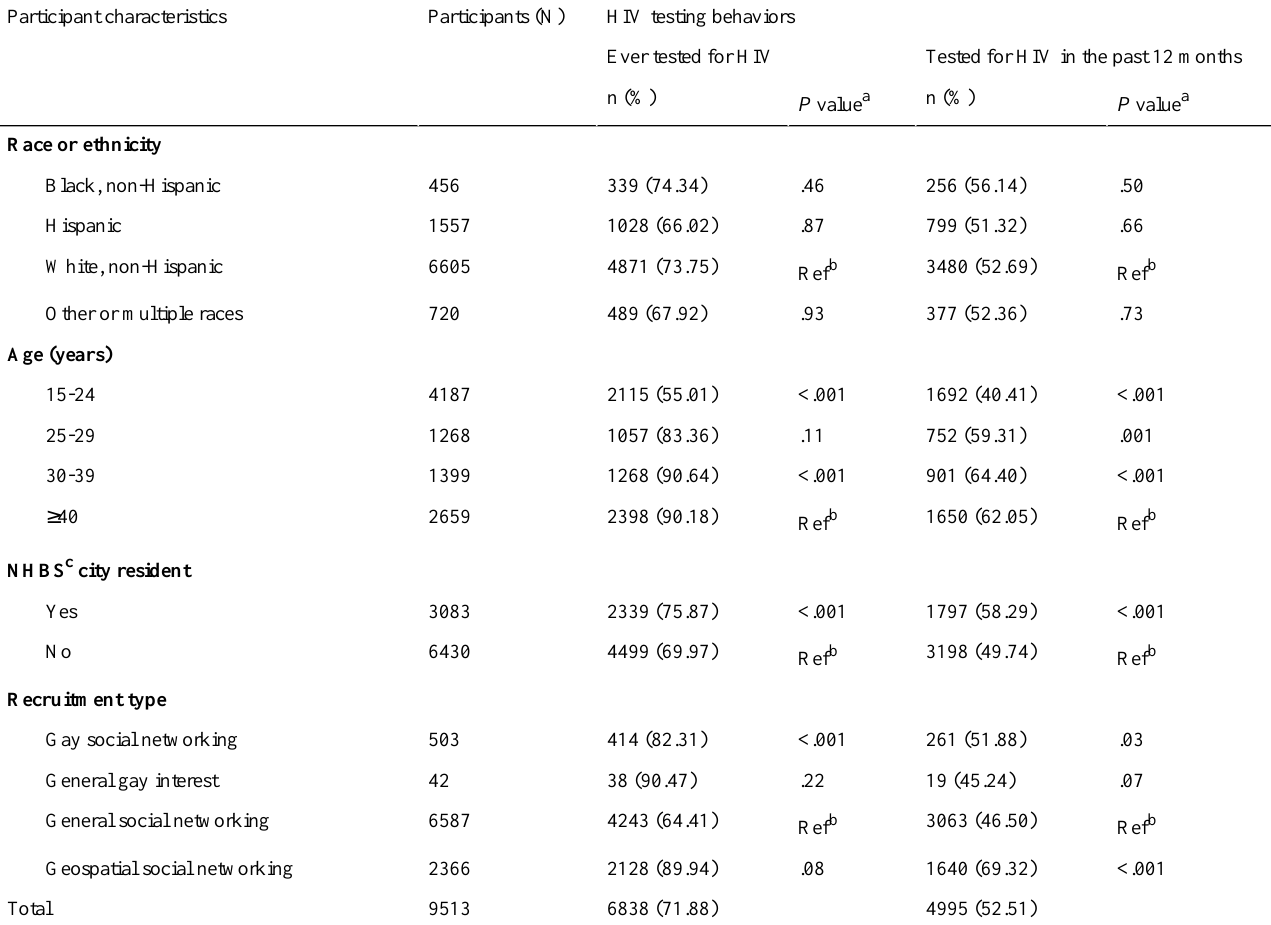
Table 5. HIV testing behaviors of HIV-negative or unknown status men who have sex with men in the American Men’s Internet Survey, United States,